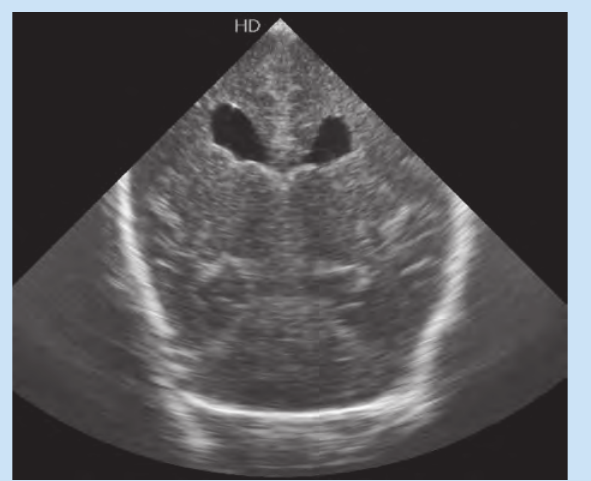
Fig. 2. Coronal US scan through the body of the lateral ventricles.